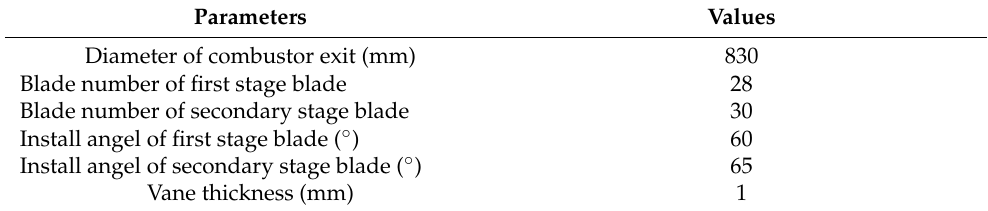
Figure 2. ( a ) Schematic diagram of the three-dimensional structure of the two-stage swirler; ( b ) the two-stage swirler used in the present experiments. Table 1. Parameters for the